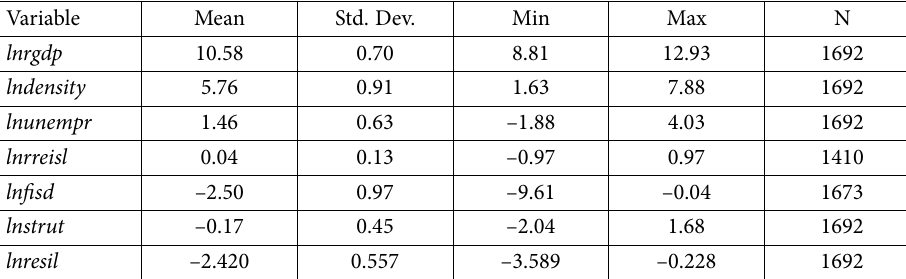
Table 2. Descriptive statistical analysis of